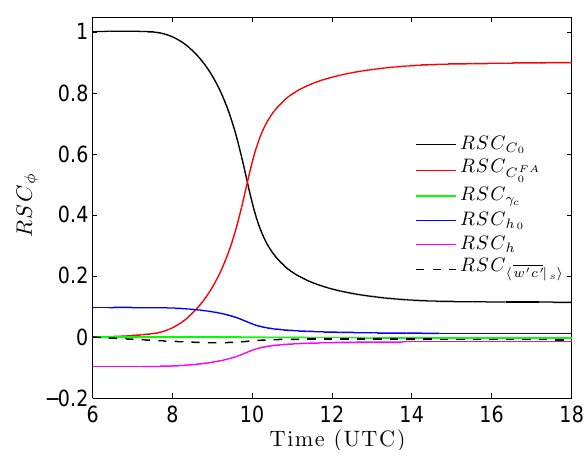
Fig.4. Timeevolutionoftherelative(normalized)sensitivityoftheCO 2 mixingratiotoallthevariables( RSC φ ,seeexpression24)forthe Fig. 4. Time evolution of the relative (normalized) sensitivity of the controlcase. CO 2 mixing ratio to all the variables (RSC φ , see expression 27) for the control